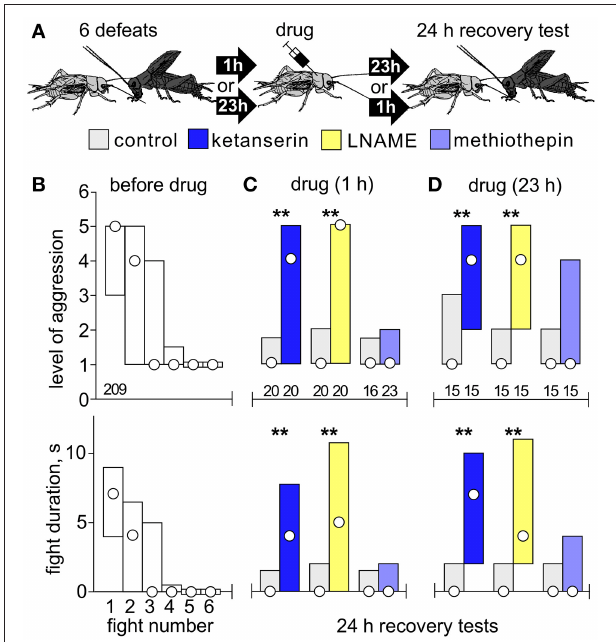
FIGURE 4 | Effects of drugs after chronic social defeat. (A) Procedure: Crickets were first matched 6 times at 1h intervals against hyper-aggressive opponents, then treated either 1h or 23h later with drug, and their aggressiveness evaluated 24h after the last defeat (recovery test). (B) Bar charts giving the level of aggression (top) and fight duration (right, circle: median, bars: interquartile range, IQR) before drug treatment (white bars). (C) As in B but 24h later for crickets that received LNAME (dark blue bars), ketanserin (yellow bars), methiothepin (pale blue bars) 1h after multiple defeat. (D) As for C , but 23h after multiple defeat. Controls received vehicle or DNAME to control for LNAME (gray